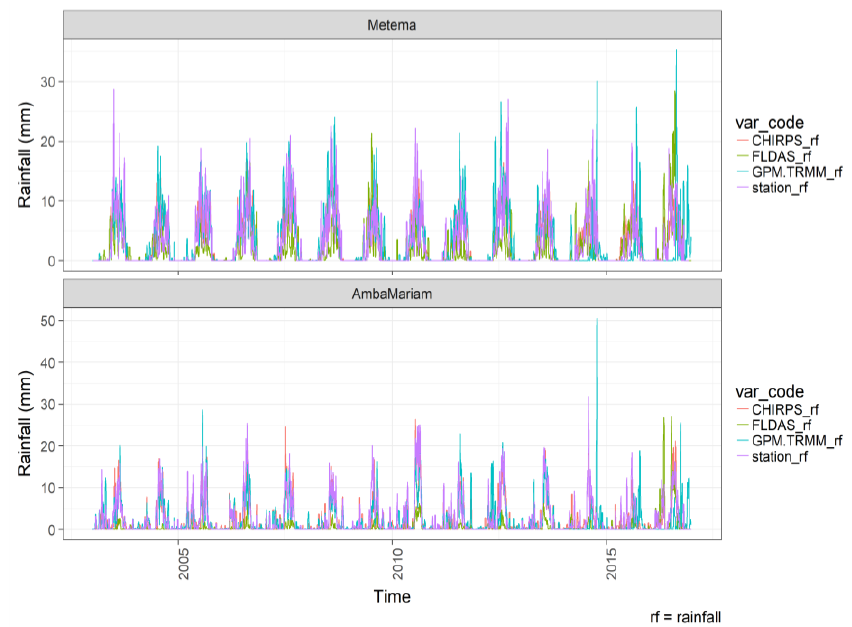
Figure 7. Time series plot of rainfall from remote sensing satellite (GPM.TRMM_rf), model driven (CHIRPS_rf, FLDAS_rf), and meteorological station (stations_rf) datasets at a lowland (Metema), and highland (Amba Mariam) stations, Northwest Ethiopia, for 2003–2016. Note the y-axis scale difference.